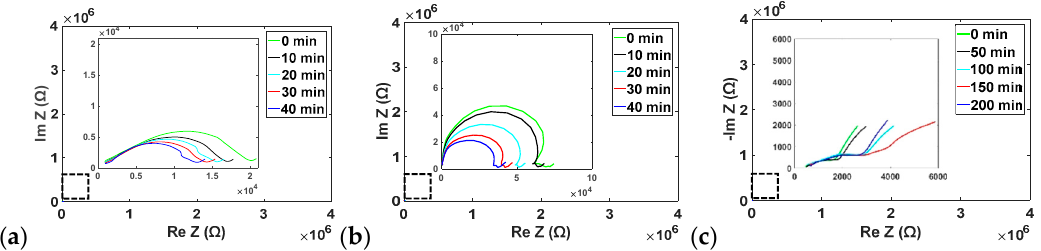
Figure 6. Representative Nyquist plots for gelatin-coated sensors to ( a ) 1 mg/mL lipase; ( b ) 1 mg/mL amylase; and ( c ) trypsin, amylase, and lipase, each at 1 mg/mL over time.